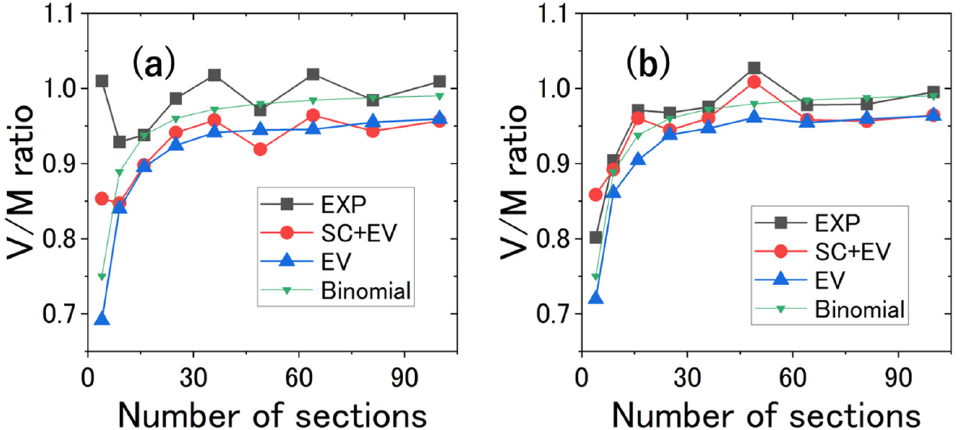
Figure 6. The V/M ratio as a function of the number of sections. The experimental results (EXP), the simulation results with both stationary cells (SC) and excluded volume (EV) effect considered, and those with only the EV effect. For reference, VMR for the binomial distribution in Equation (8) is displayed. VMR for the hypergeometric distribution in Equation (4) is evaluated to be nearly (~99%) the same as that for the binomial distribution. ( a ) The average number of cells per frame was 185.18; the average number density per mm 2 was 139.95. Assuming that each cell is a circle with a diameter of 10 µ m, the area fractions of all the cells in 2D space was 1.1%. The volume fraction in 3D space was 0.76% when each cell was assumed to be a sphere with a diameter of 10 µ m. The same data as in Figure 3 were used. ( b ) The average number of cells was 104.66. The average number density per mm 2 was 80.04 and the area fraction was 0.6%. The volume fraction was 0.41%.